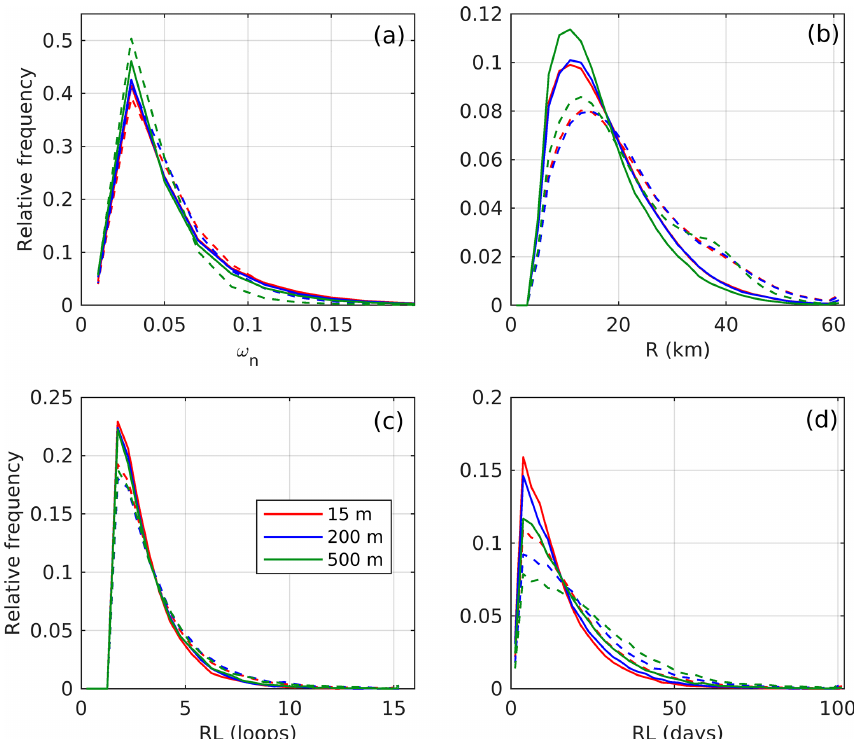
Figure 5. Relative frequency distributions (RFDs) of (a) the non-dimensional frequency ( ω n ), (b) the mean geometric radius ( R ), i.e., the estimated instantaneous radius of the associated eddies, (c) the length of the ridges in cycles, RL (loops), and (d) length of the ridges in days, RL (days). RFDs are for all ridges found from the 3D drifters deployed at 15m (red), 200m (blue) and 500m (green) and shown for both cyclonic ridges (solid) and anticyclonic ridges (dashed). The RFDs are created after binning each quantity and are normalized by the total number of cyclonic and anticyclonic ridge points,